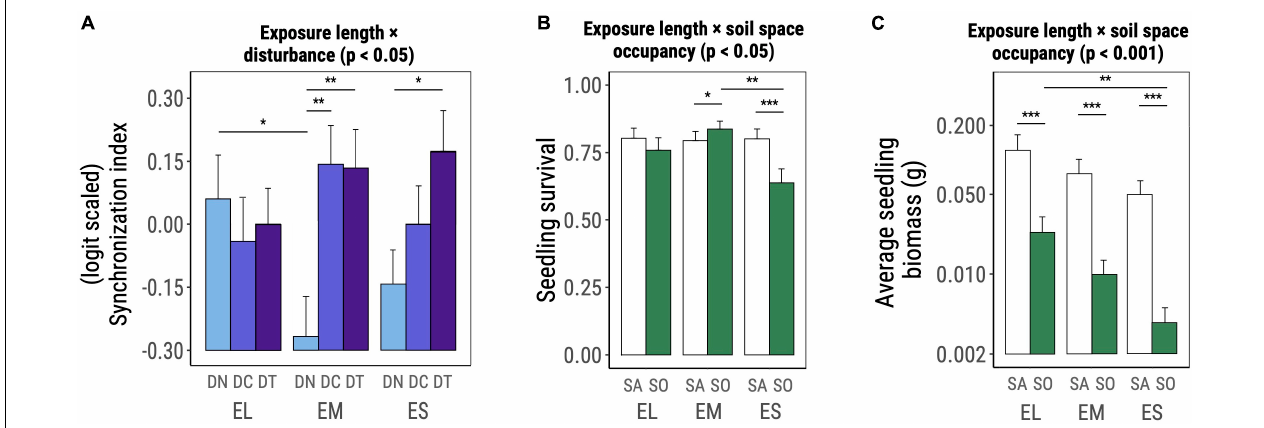
FIGURE 3 | Significant interactive effects of exposure-length group × disturbance (A) and exposure-length group × space occupancy (B,C) on early life performance of the studied invasive plant species as determined based on Wald χ 2 tests on (generalized) linear mixed effects models (significance level noted on top of the plot). Graphs show marginal means and standard errors estimated by the corresponding model. Horizontal bars denote significant differences among levels of each factor within levels of the other factor involved in the interaction and were assessed based on post hoc comparisons on marginal estimated means. Abbreviations and color codes: EL, exposure long species; EM, exposure medium species; ES, exposure short species; light blue DN: no disturbance; blue DC: disturbance compaction; purple DT: disturbance tilling; white SA: space available; green SO: space occupied. Significance levels: * p ≤ 0.05; ** p ≤ 0.01; *** p ≤